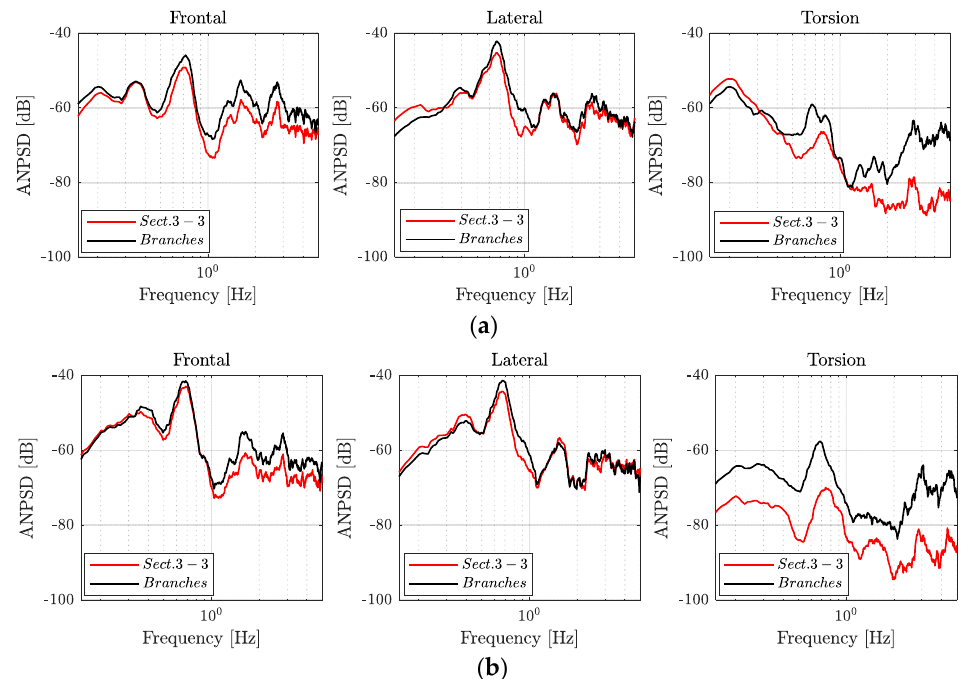
Figure 11. The ANPSDs estimated in the trunk (Section 3-3) and on the branches for the consid- ered tests: ( a ) in Test #3 and ( b ) Test